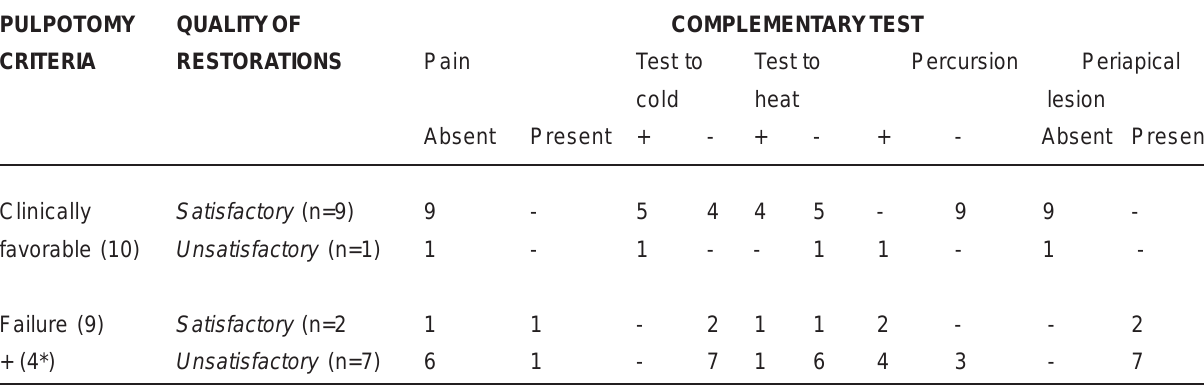
* four teeth were categorized as “failure” due Endodontic therapy presence(2) or extraction (2). Teeth with endodontic therapy were excluded of restoration